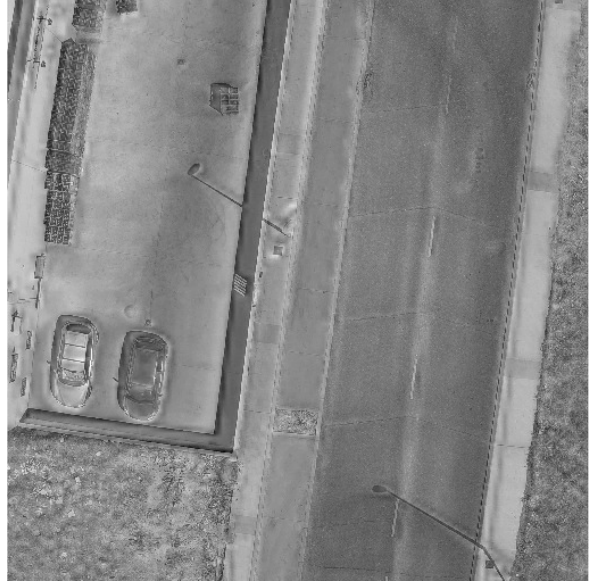
Figure 4. Enhanced thermal image raw band by the IHS pansharpening algorithm, from the UAV image dataset